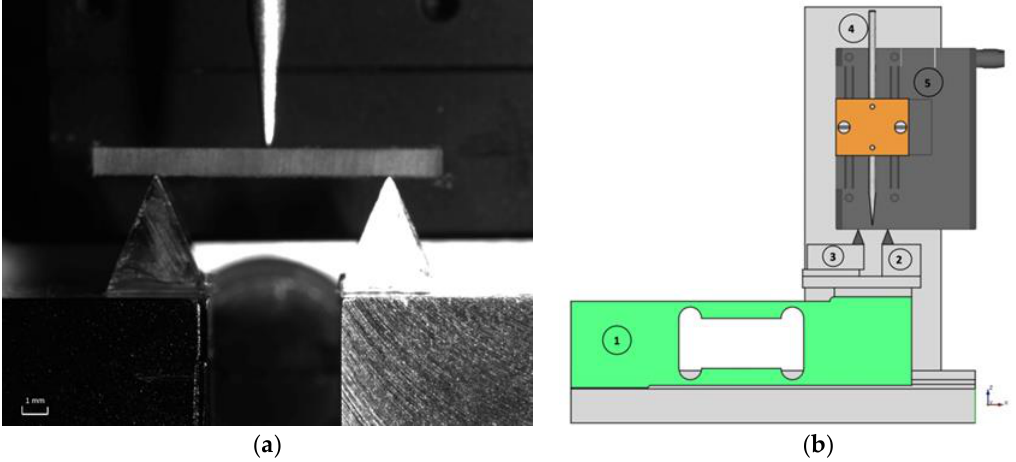
Figure 1. ( a ) Close-up of the support system. ( b ) Schematic drawing of the setup. 1-Load cell, 2- specimen support, 3-horizontal translation stage, 4-indentation stylus, 5-motorized translation